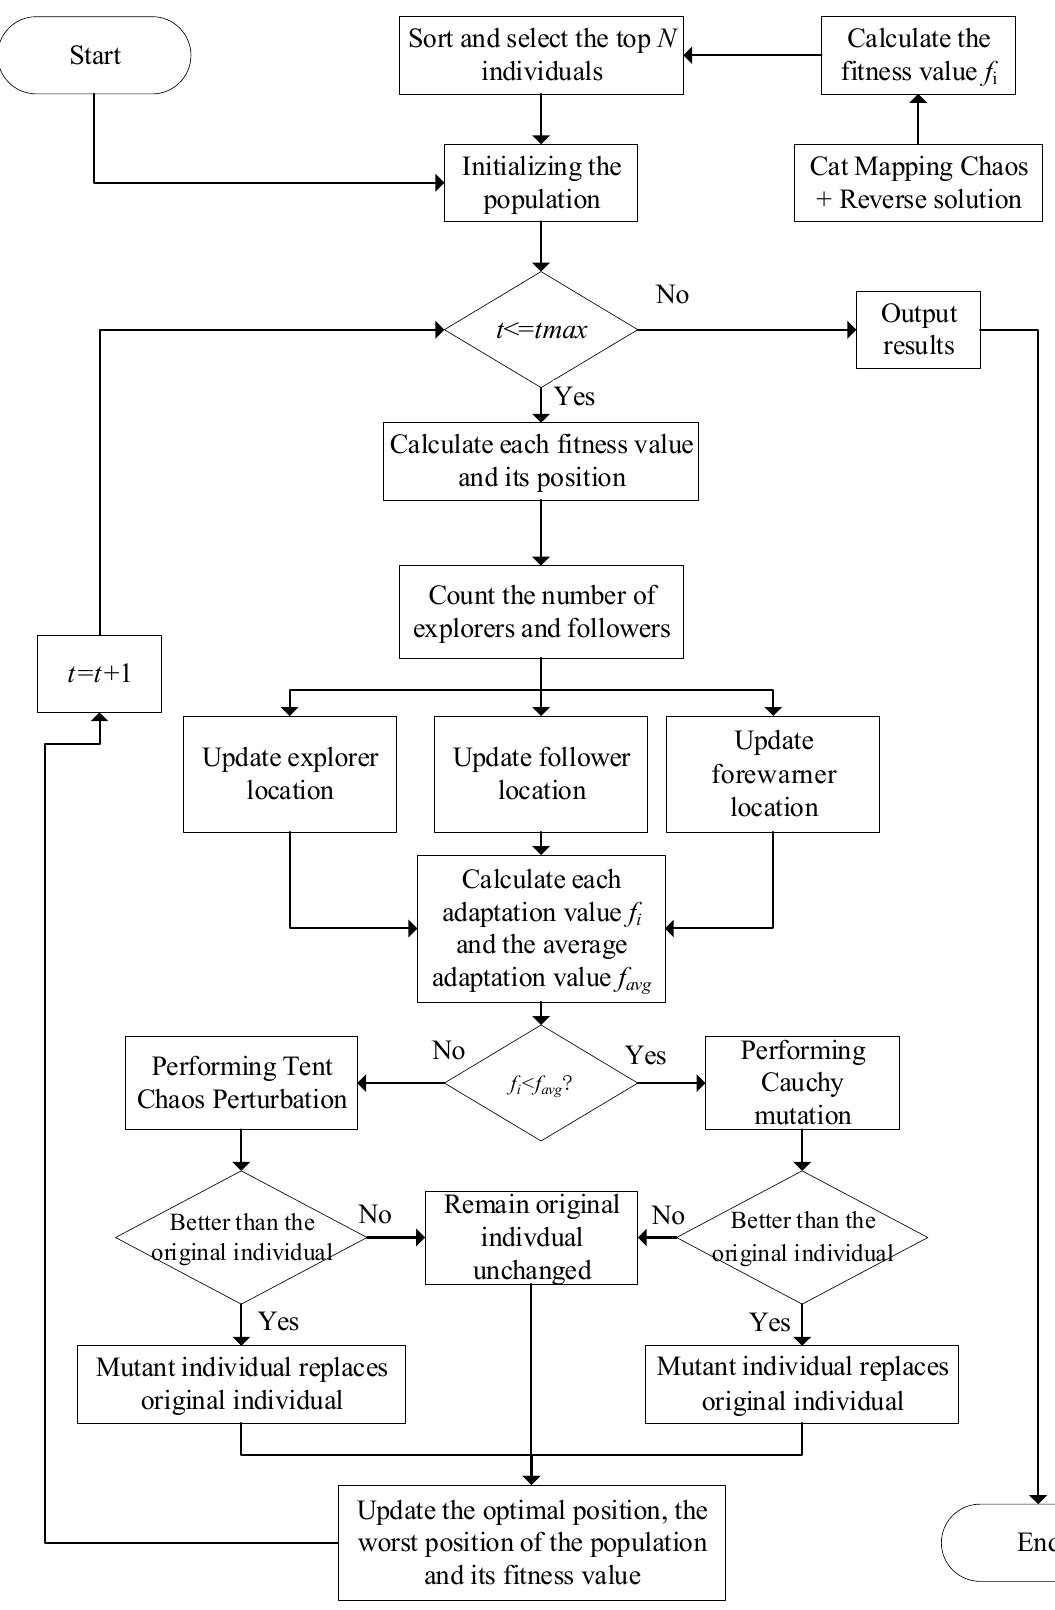
Figure 3. Flow chart of ISSA.